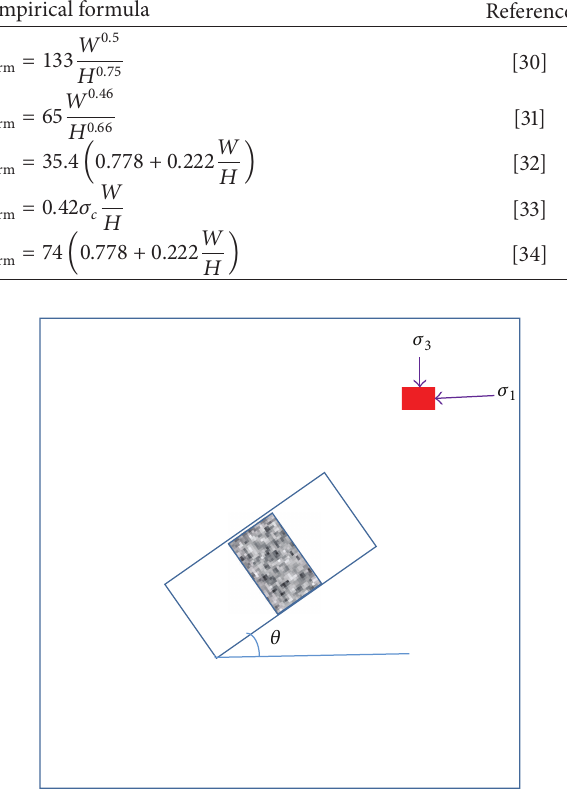
Table 2: Empirical formulae for hard rock pillar strength. Empirical formula